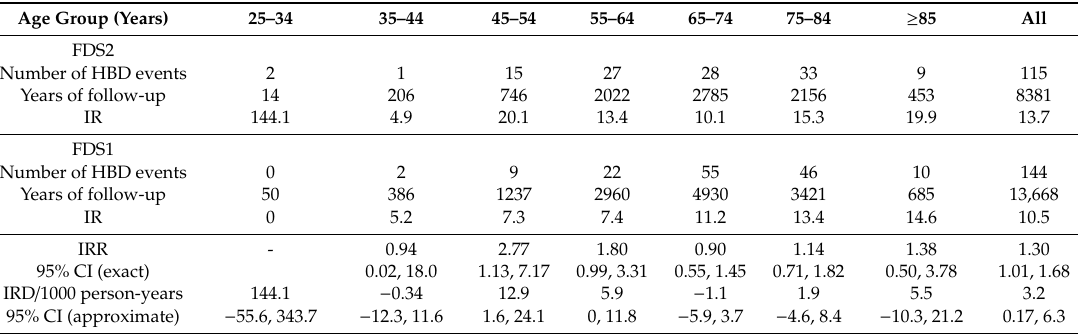
Table 3. Age-specific incidence rates (IRs) per 1000 person-years, incidence rate ratios (IRRs), and incident rate di ff erences (IRDs) for first-ever hospitalization for / with or cancer registration or death from / with hepatobiliary disease (HBD) in type 2 diabetes for the Fremantle Diabetes Study Phase II (FDS2) versus the Fremantle Diabetes Study Phase I